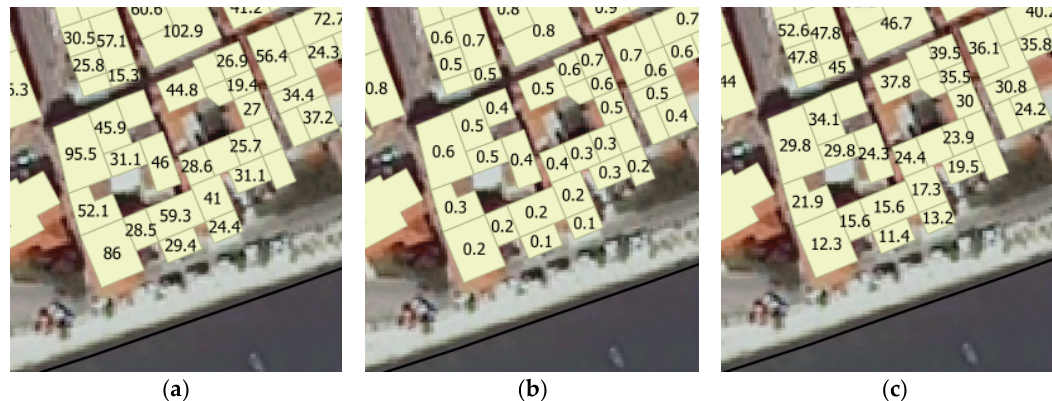
Figure 2. Maps showing the key geospatial parameters for each building in the study area: ( a ) the Figure 2. Mapsshowingthekeygeospatialparametersforeachbuildinginthestudyarea: ( a